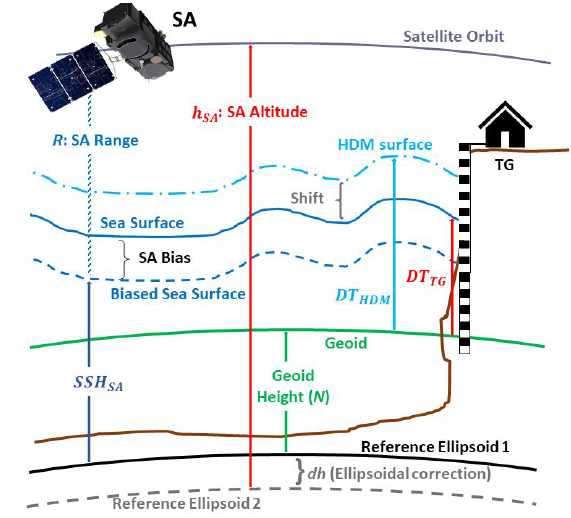
Figure 1: Interrelations between observations, data models and reference surfaces. Consult the main text body for the used symbols and